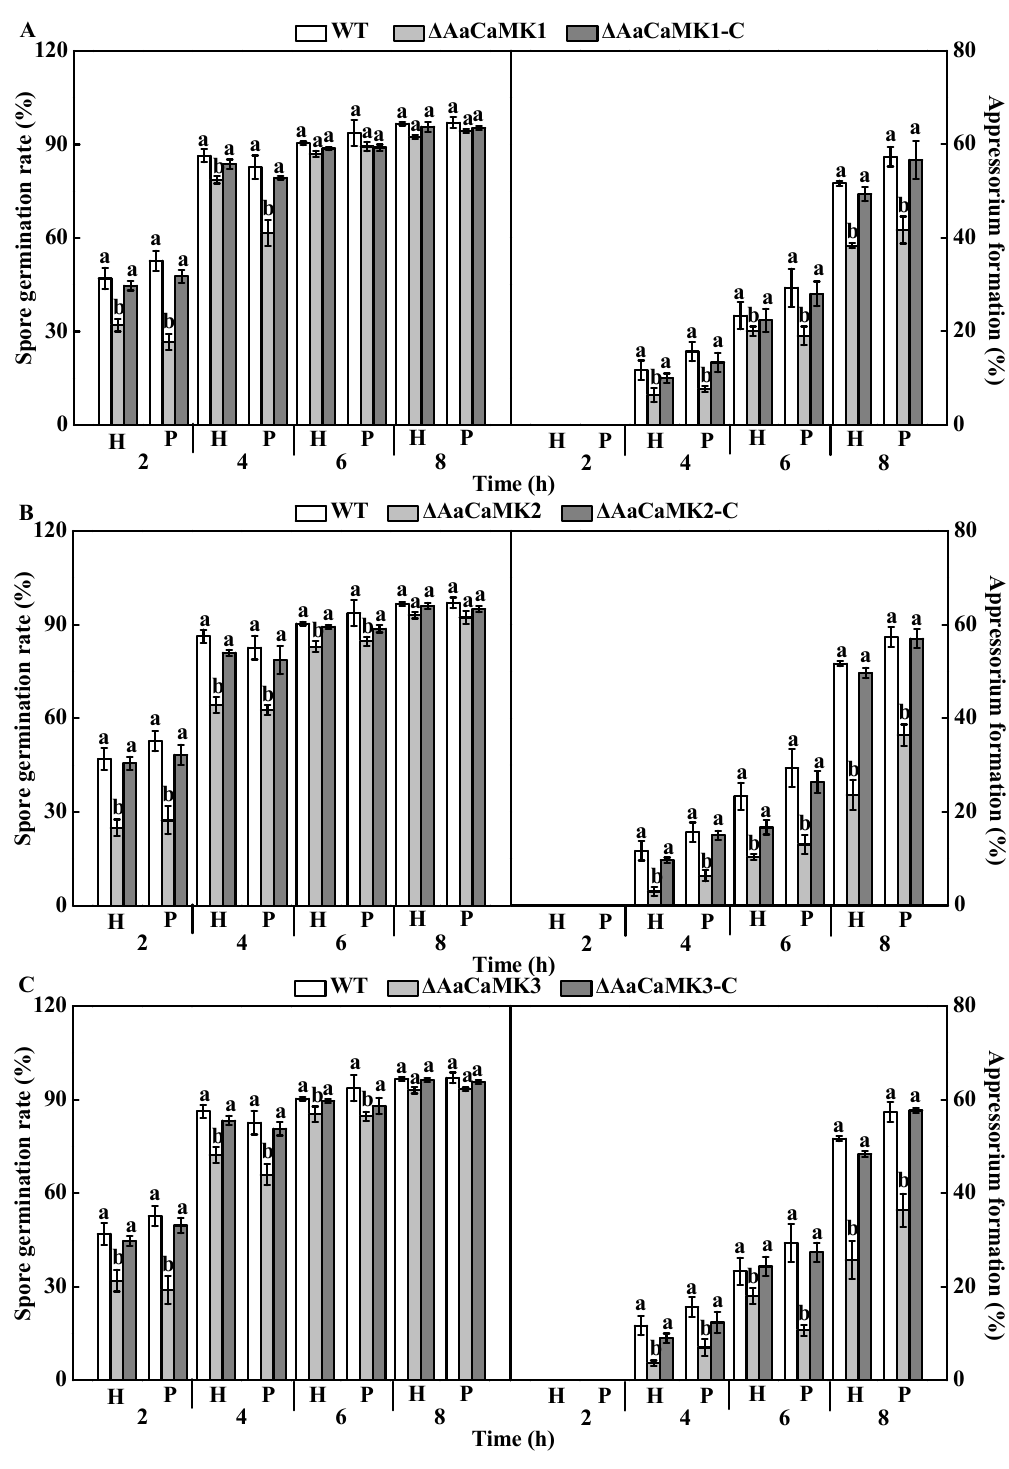
Figure 6. The spore germination and appressorium formation of AaCaMK1 ( A ), AaCaMK2 ( B ) and AaCaMK3 ( C ) induced by hydrophobic (H) and pear wax (P). Bars indicate standard error (±SE). Different letters indicate significant differences ( p < 0.05).